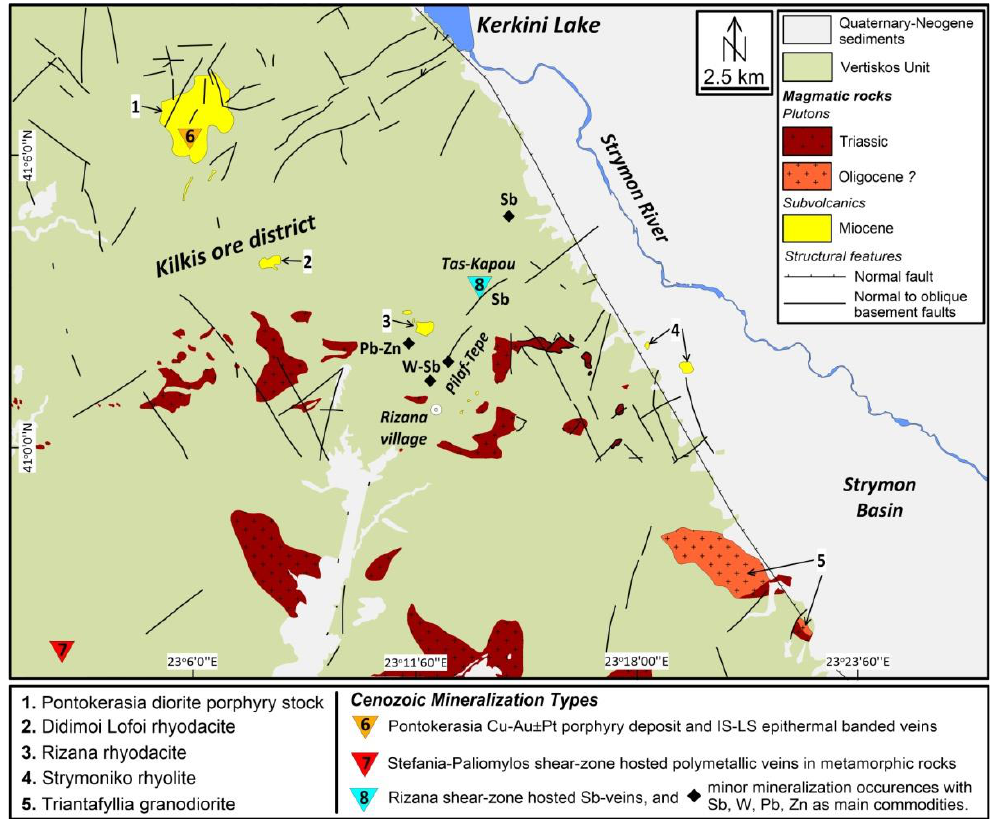
Figure 2. Geological map of the Rizana region (for the location of the map see Figure 1, modified after [23,24,35,41 – 43]).